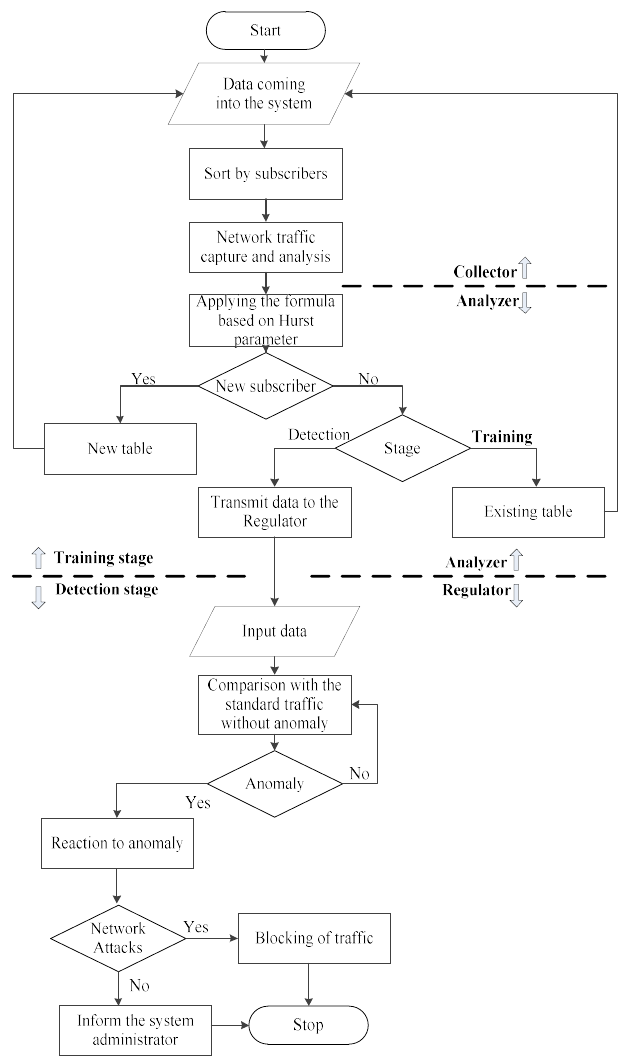
Figure 1. Block diagram of the anomaly detection algorithm.